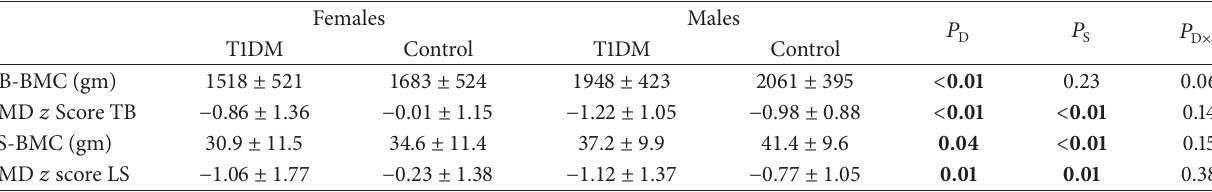
Table 5: The bone mineral content and bone mineral density 𝑧 scores of TB and LS and the age, height, and weight adjusted contributions of diabetes (D) and sex (S) and their interaction (D × S) (expressed as mean ± SD). Females